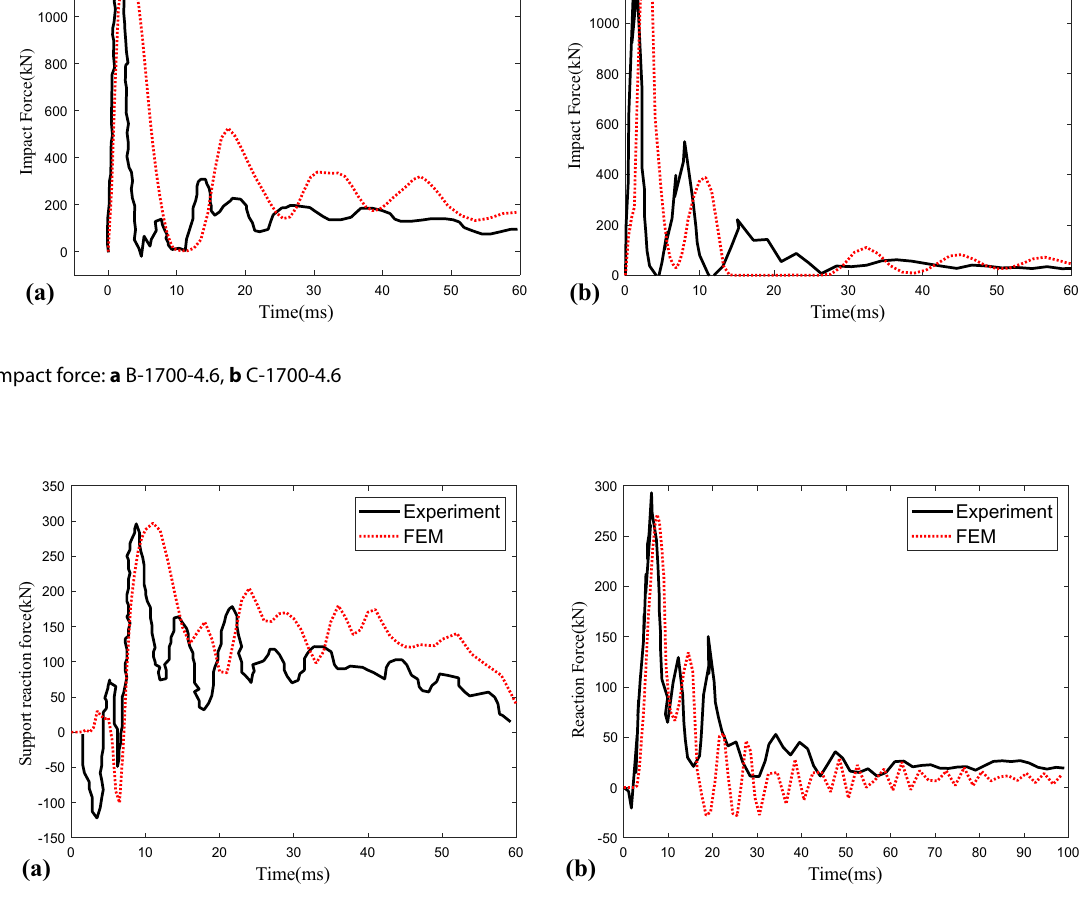
Fig. 7 Support reaction force: a B-1700-4.6, b